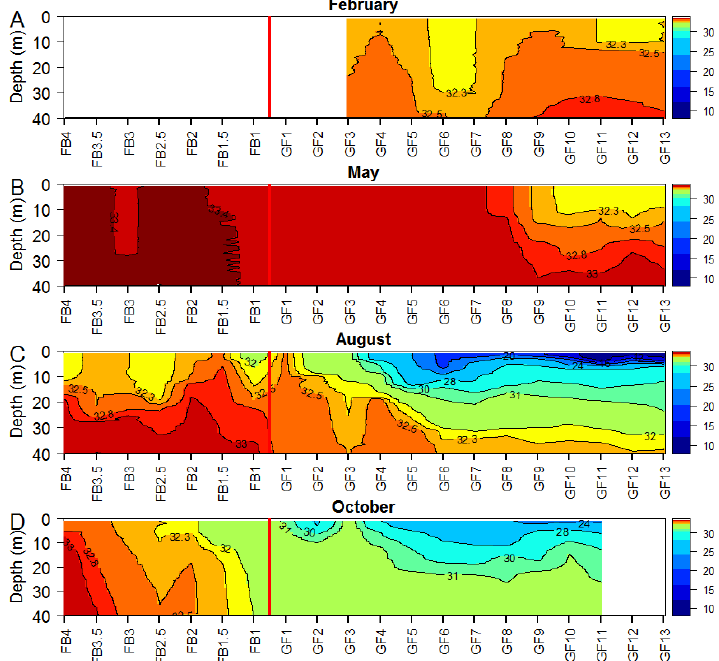
Figure 3. Transects of salinity from the shelf (left) to the glaciers (right) during February (a) , May (b) , August (c) and October (d) 2013. The red line indicates the mouth of the Godthåbsfjord area.